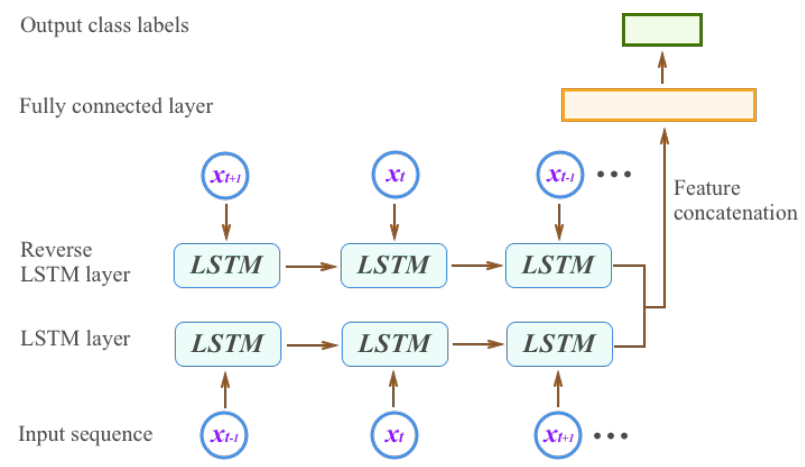
Figure 5. The network structure of trajectory classification using bidirectional LSTM (BiLSTM).